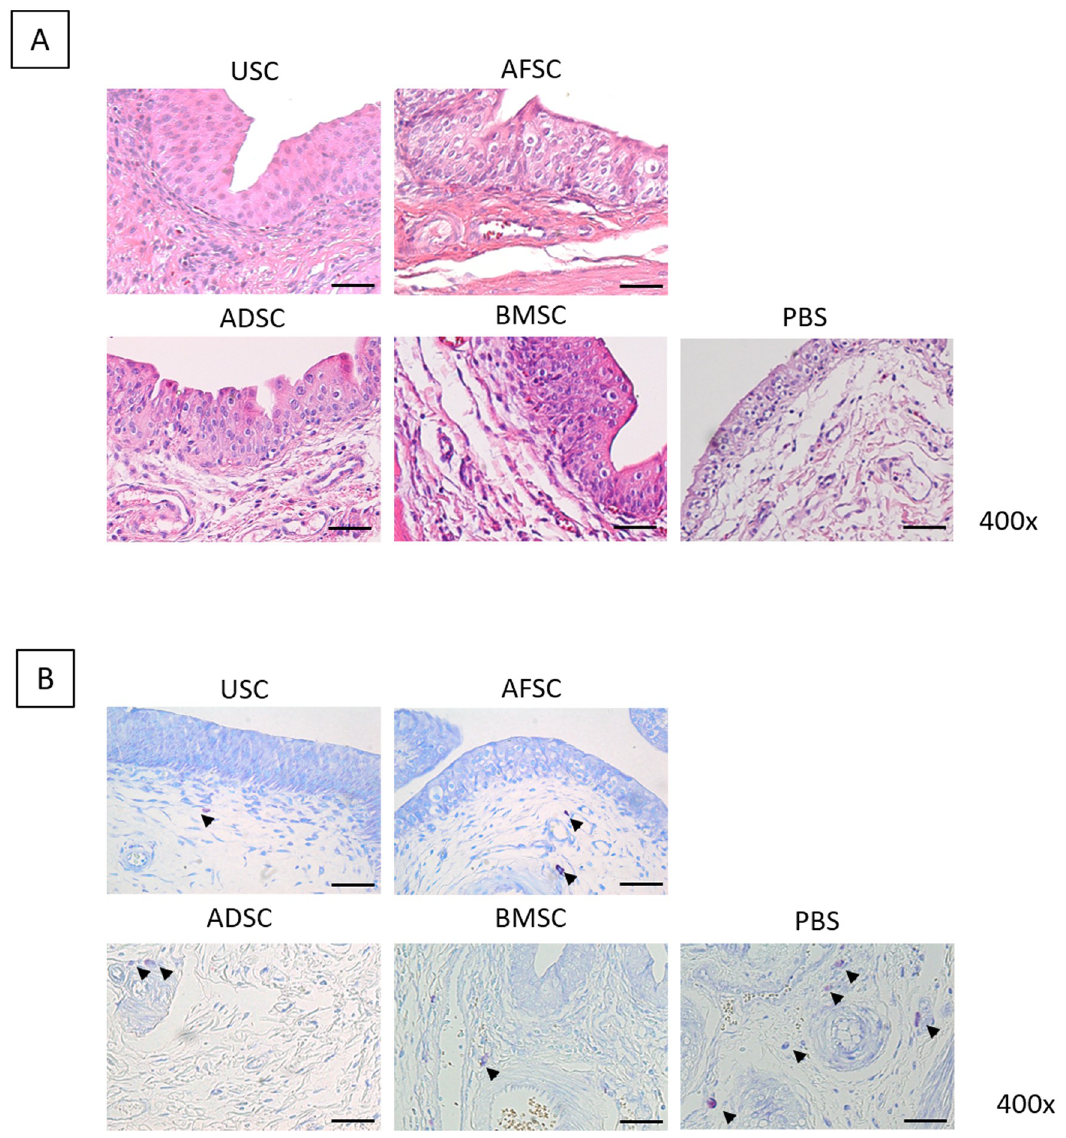
Fig 1. Histological results in USC-, AFSC-, ADSC-, BMSC- and PBS-injected groups. (A) H&E histological examination showed no significant differences in urothelium and smooth muscle regeneration among stem cell (SC)-treated groups. (B) SC-injected groups showed significantly reduced positive mast cell numbers compared with PBS